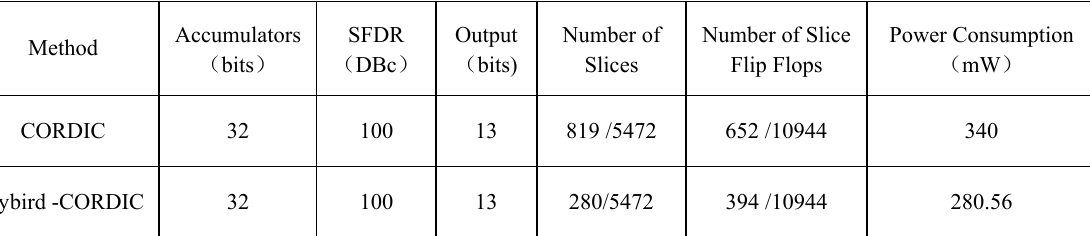
Table 1 comparison with recently proposed